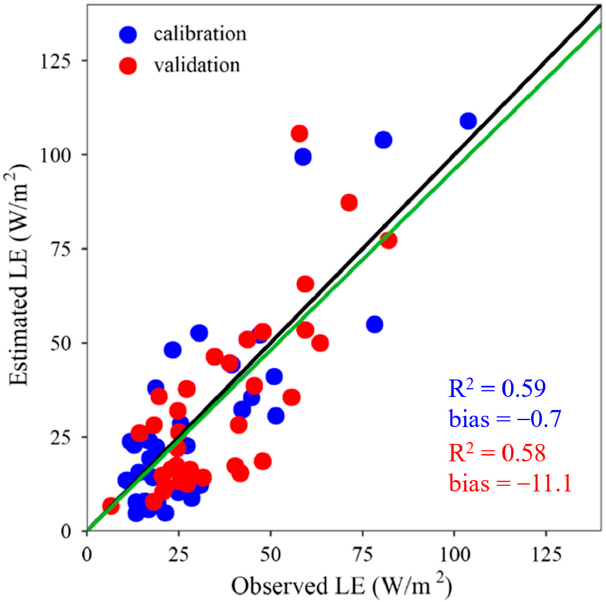
Figure 8. Comparison of the observed and simulated half-hourly LE values of all 109 study periods. The red and blue filled dots represent the values from the calibration and validation sets. The black and green lines are the 1:1 and linear regressed lines without intercept, respectively.